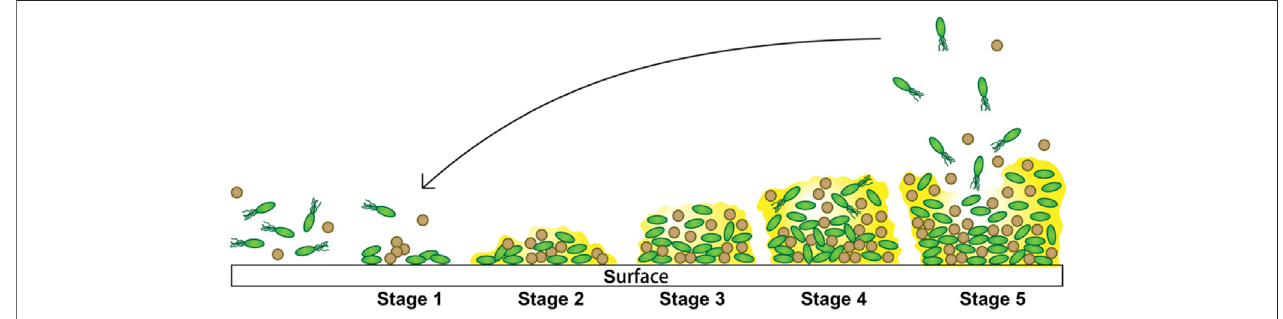
FIGURE1| Stepsinvolvedinbio fi lmformation.1)Initialattachment.2)Extracellularpolymericsubstanceproduction.3)Bio fi lmdevelopment.4)Bio fi lmmaturation. 5) Dispersion from the bio fi